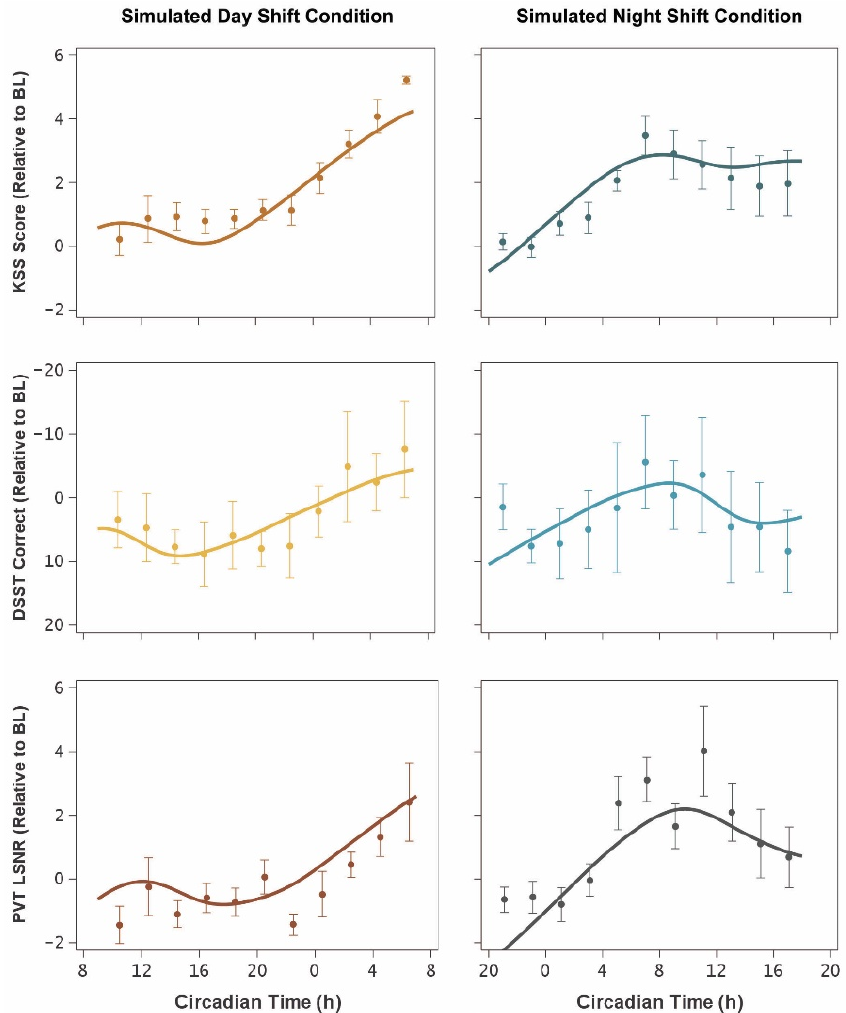
Figure 3. Temporal profiles of neurobehavioral functioning during the 24 h CR protocol. The graphs show means (±SE) for KSS ( top ), DSST ( middle ), and PVT ( bottom ), expressed relative to baseline (BL) and plotted against mean circadian time (i.e., relative to DLMO), for the simulated day shift condition (left) and the simulated night shift condition (right). Curves represent the mean (accounting for inter-individual differences) of the fitted statistical model of Equation (5). Upwards indicates worse neurobehavioral functioning in all